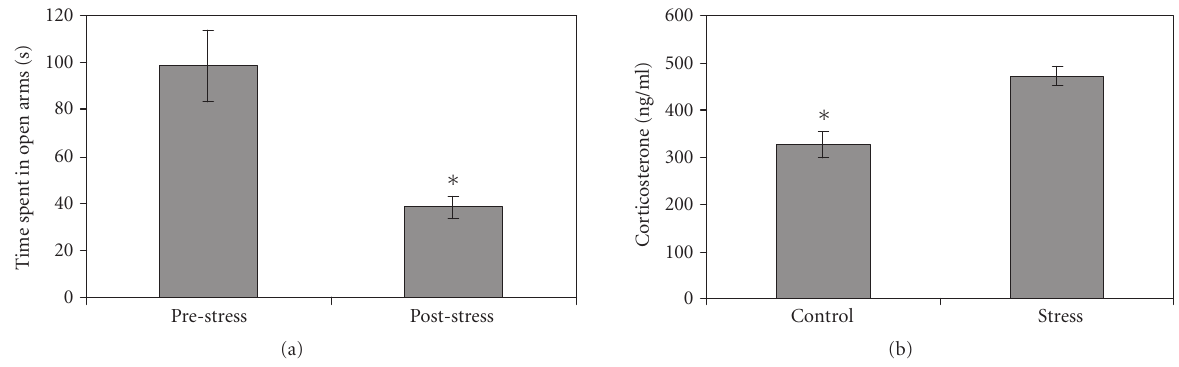
Figure 1: (a) Time spent in open arms of the elevated plus maze before and after exposure to stress . Following exposure to acute swim stress, rats spent less time in the open arms of the maze in comparison to the time spent in the open arms prior to the stress procedure ( n = 8, P < .005), indicating increased anxiety. (b) Levels of corticosterone in control and stress rats . Acute swim stress induced elevation of serum corticosterone in the stressed rats ( n = 6) compared to control rats ( n = 8, P < .005).